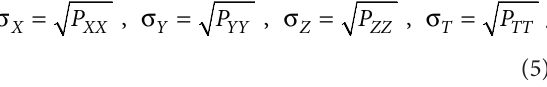
Jenkin 2000) in formula (2).